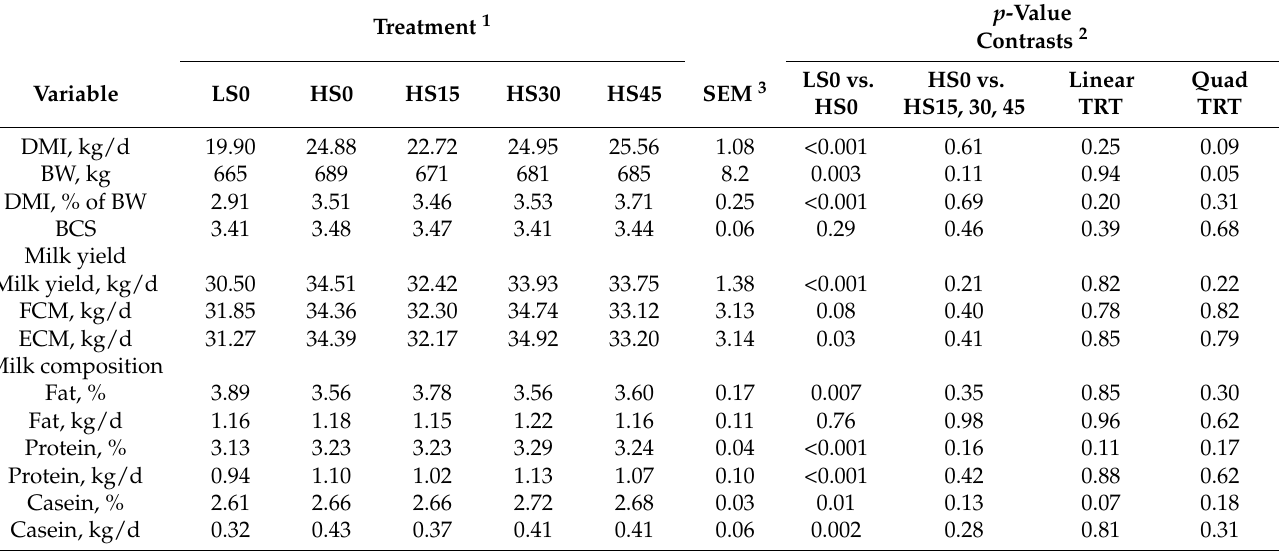
Table 3. Least squares means and associated SEM for BW, BCS, and production parameters of Holstein cows on low-starch diets without autolyzed yeast products (LS0), high-starch diets without autolyzed yeast products (HS0), and HS with 15 g (HS15), 30 g (HS30), and 45 g (HS45) of autolyzed yeast during the experimental period. Treatment 1